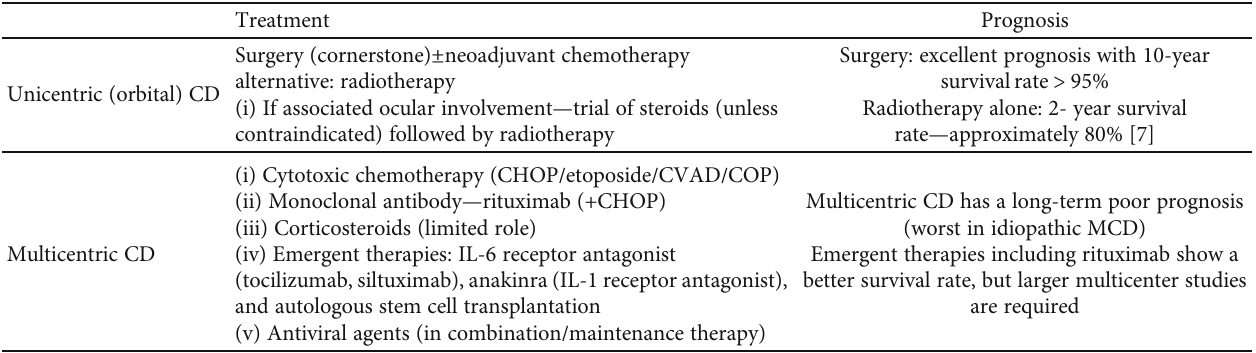
Table 1: Management of CD: an